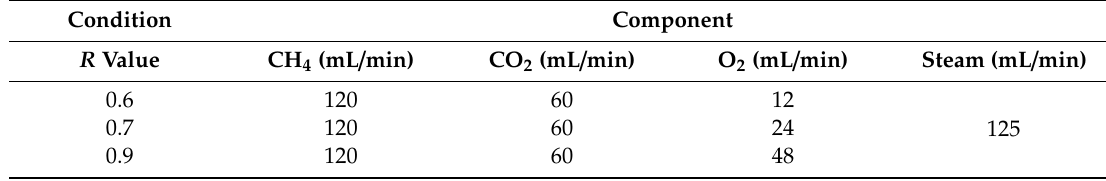
Figure 4. Experimental apparatus and reactor. Table 2. Experimental conditions for biogas reforming.